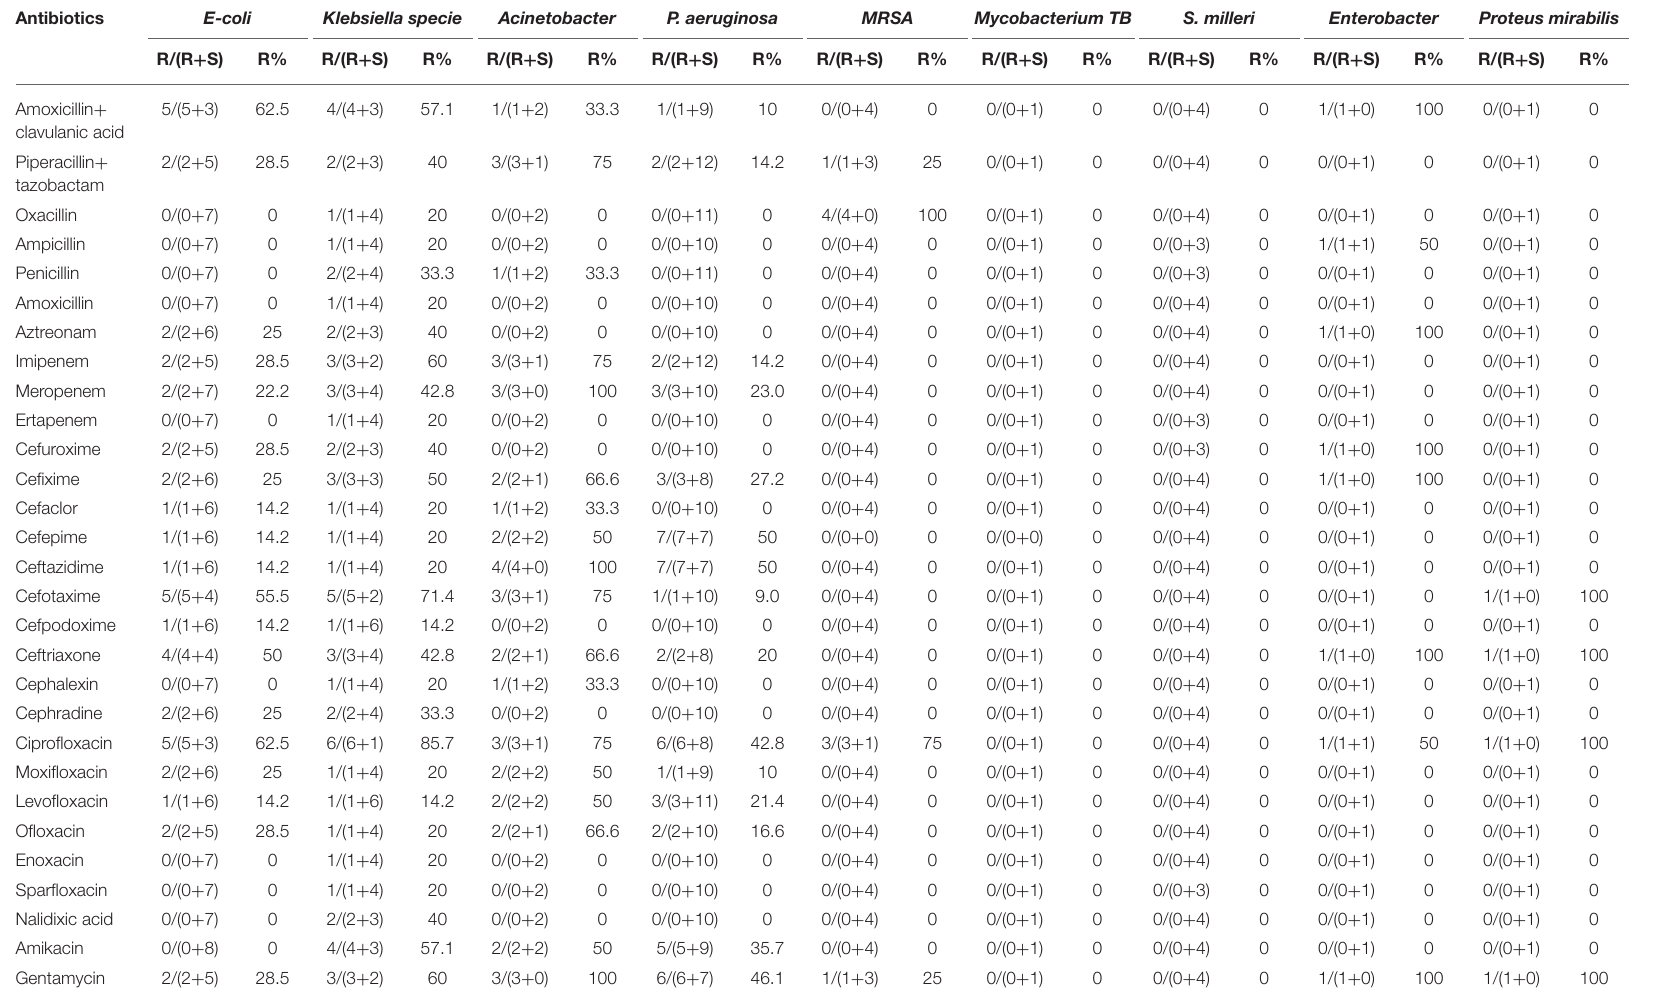
TABLE 3 | Percentage resistance of organism isolates against antibiotics ( N =